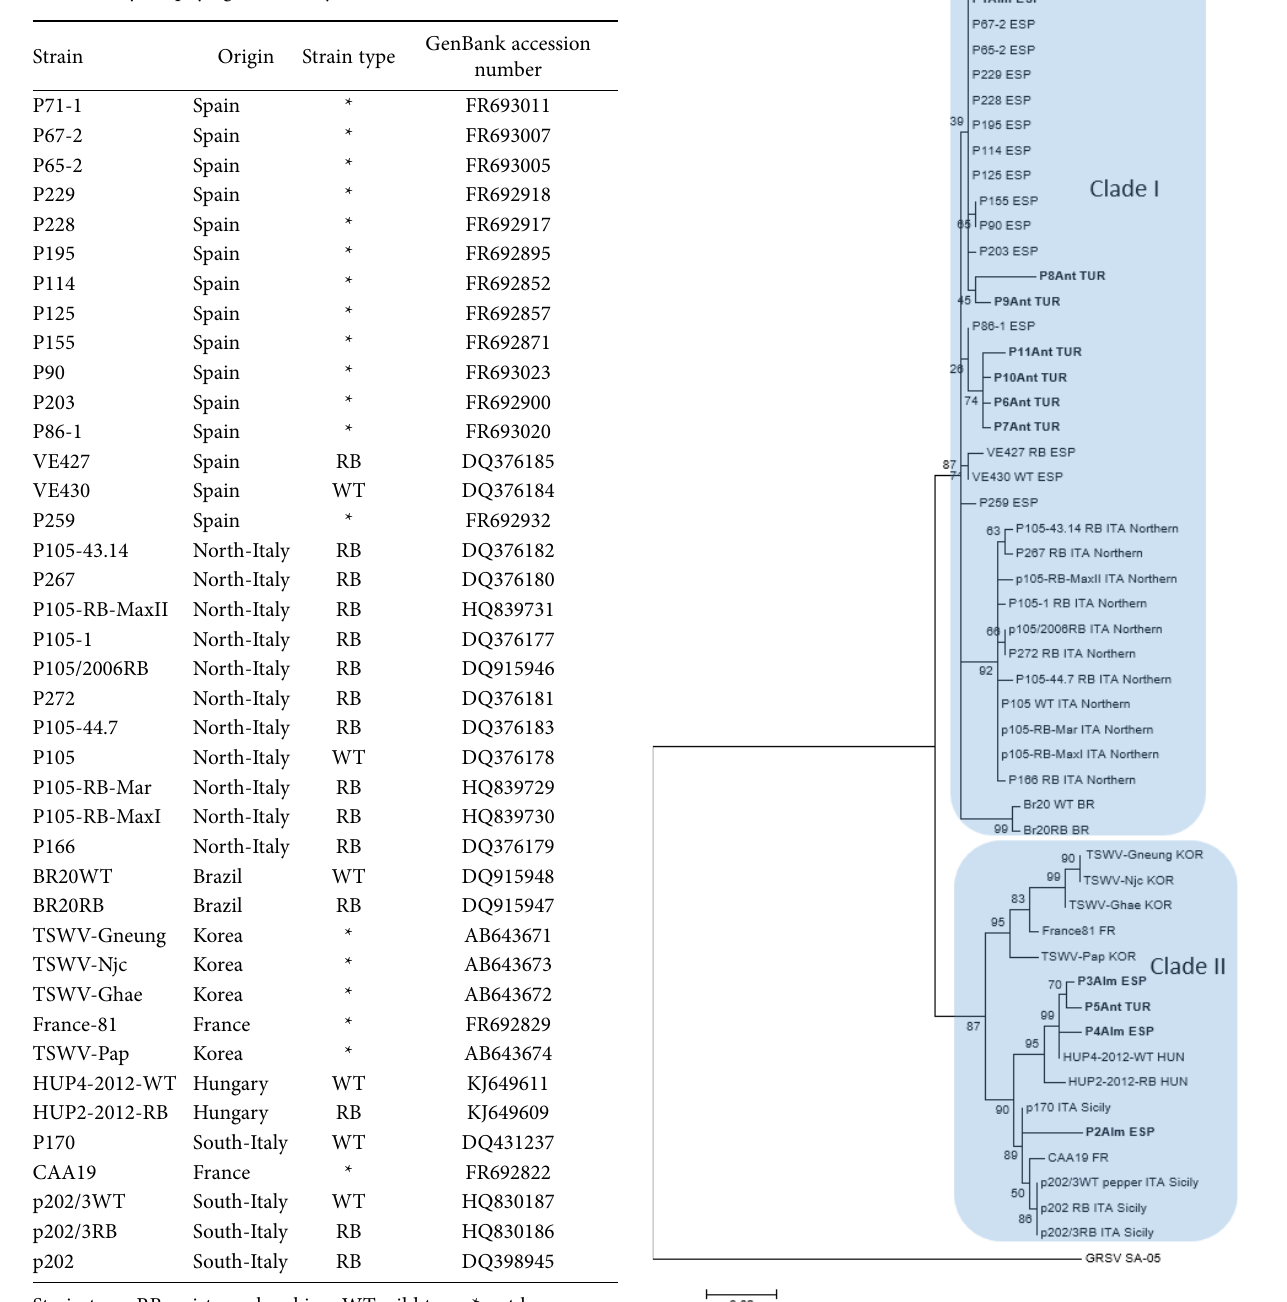
Table 2. GenBank accession numbers of the TSWV strains selected in this study for phylogenetic analyses.